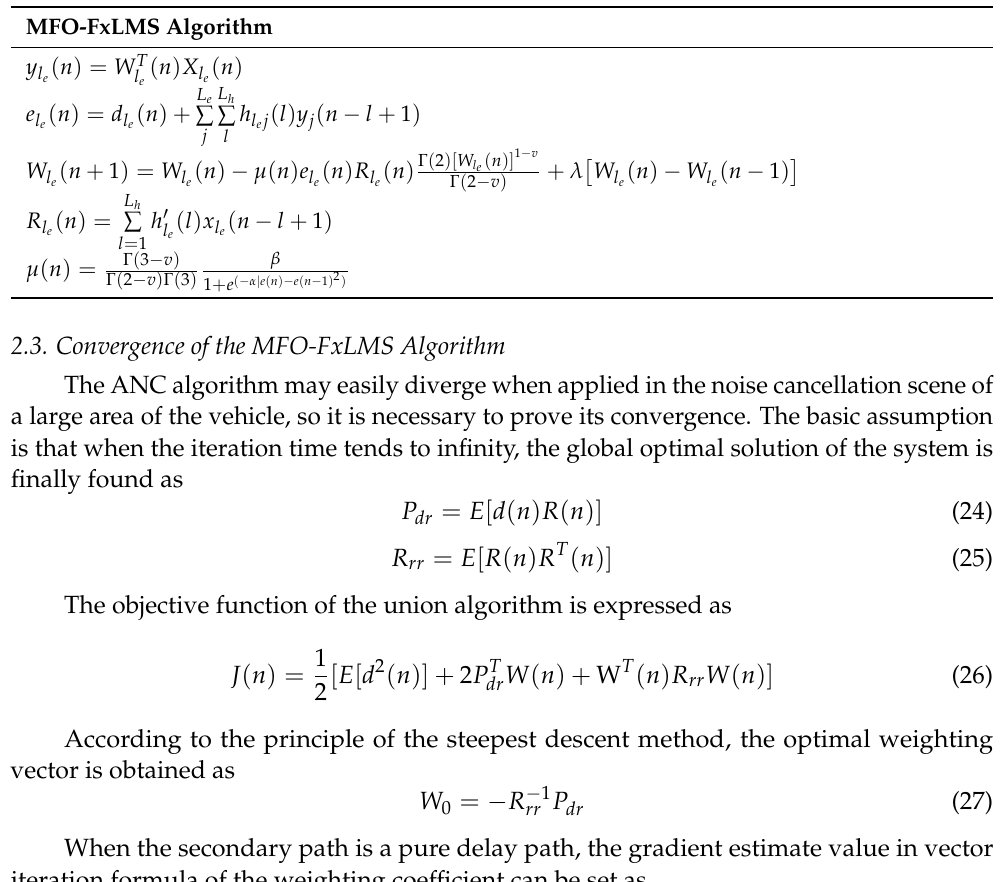
Table 1. Multi-channel fractional-order ANC (MFO-FxLMS)